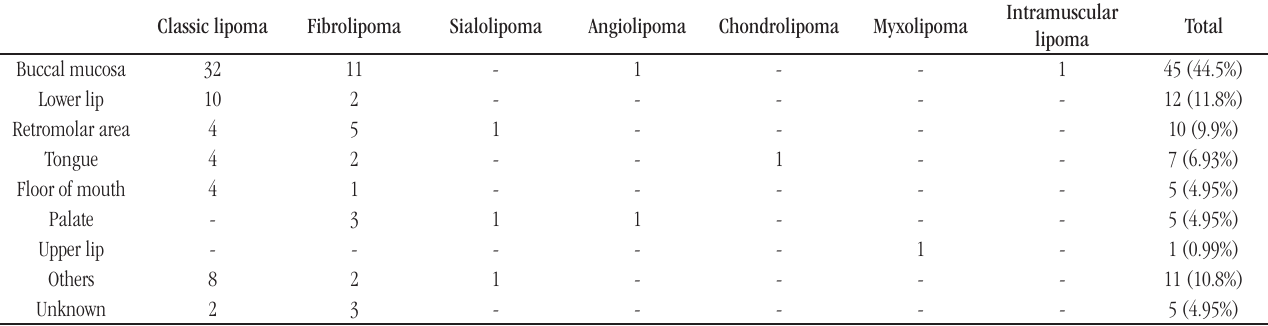
taBLE − Anatomical sites of oral cavity lipomas; Fortaleza, Brazil,